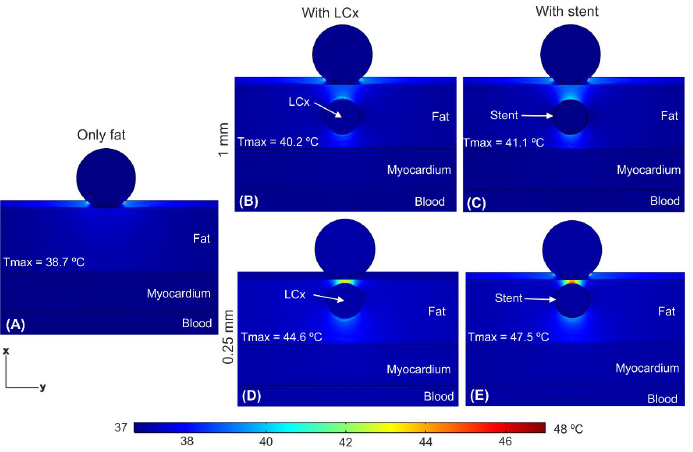
Figure 7. Temperature distributions just after applying a pulse train with time between pulses of 10 μs (see Figure 3B) comparing different conditions: ( A ) epicardial fat layer without LCx, the LCx at 1 mm from the ablation device without ( B ) and with ( C ) with the metal stent, and the LCx at 0.25 mm without ( D ) and with ( E ) the metal stent.